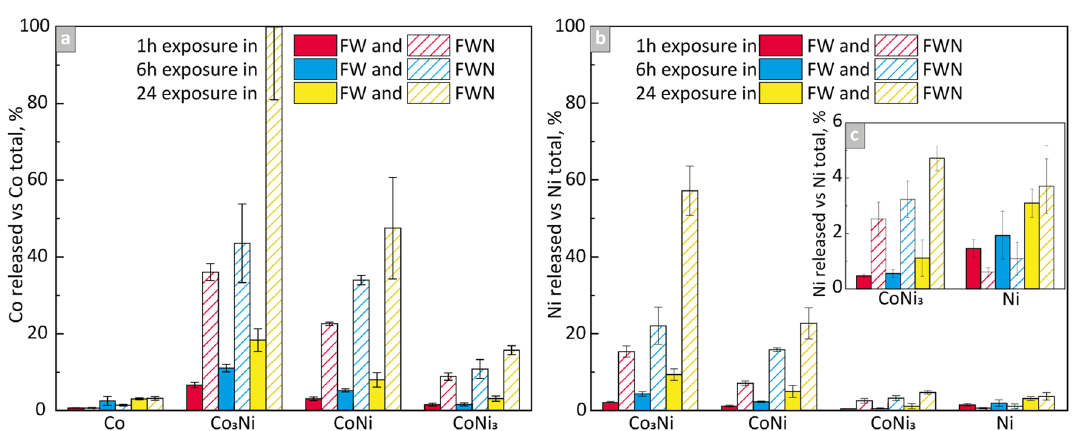
Figure 6. Released amount of ( a ) Co and ( b ) Ni versus the total amount of each metal within the particle loading of the Co- and Ni-containing NPs after 1, 6, and 24 h of exposure in synthetic FW with and without NOM. ( c ) enlarged view of the Ni release from the Ni and CoNi 3